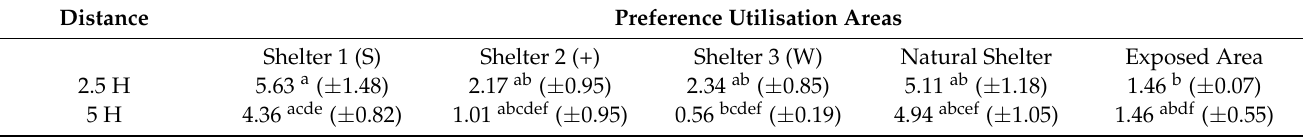
Table 3. Ewe preference index values for zones defined using 2.5 and 5 times the shelter height to define the sheltered region and the exposed area of the trial field. Data are mean ± standard error ( n = 6) with superscript letters indicating statistically significant ( p < 0.05) difference between